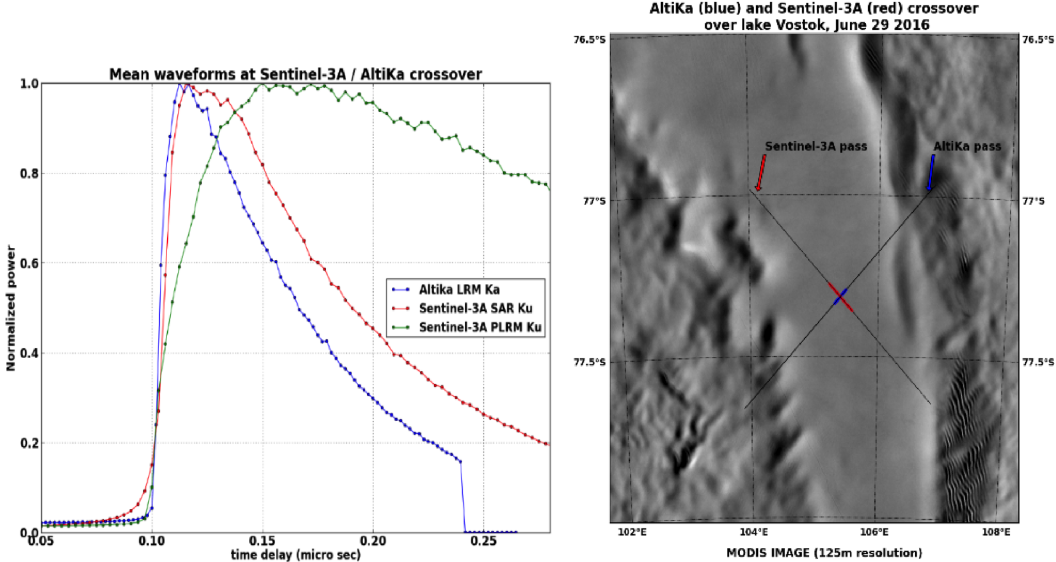
Figure 17. Left : Mean SARAL/AltiKa (blue) and Sentinel-3A (SAR in red, P-LRM in green) waveforms at a cross-over between SARAL/AltiKa and Sentinel-3A over Lake Vostok. Right : MODIS image of Lake Vostok with SARAL/AltiKa and Sentinel-3A tracks